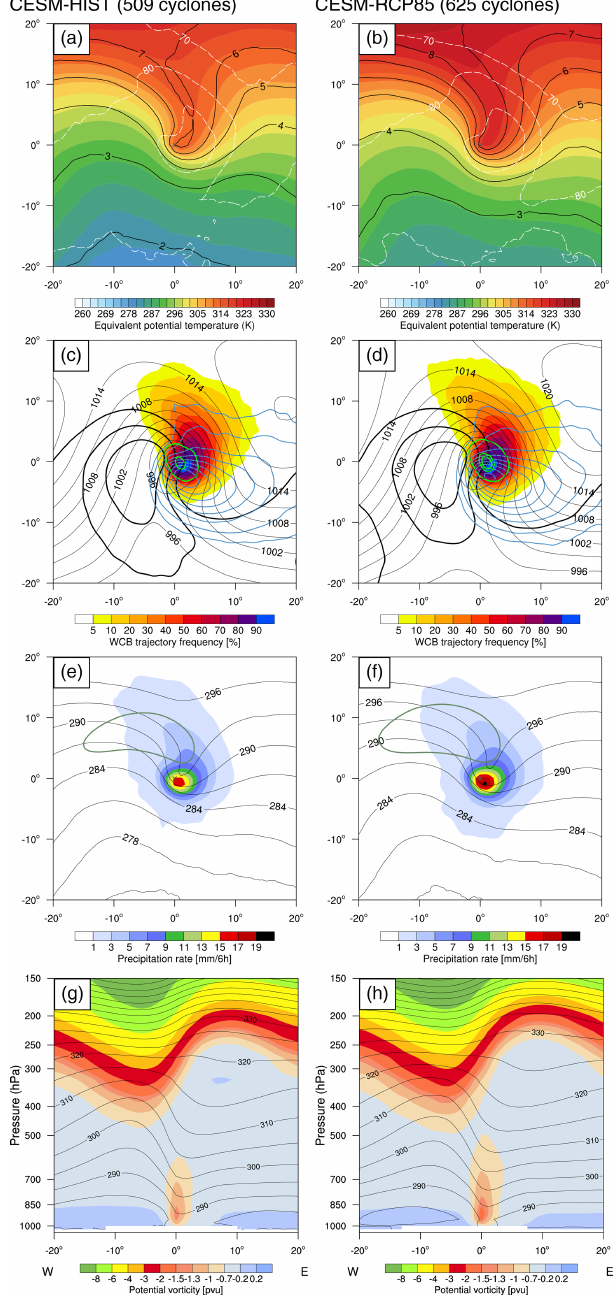
Figure 7. Composites of C1 cyclones in NH winter in (a, c, e, g) CESM-HIST and (b, d, f, h) CESM-RCP85 in the middle of the 24h period of strongest deepening. (a, b) Equivalent potential temperature (K; shading), specific humidity (black contours every gkg − 1 ), and relative humidity (dashed white contours every 10%) at 850hPa. Fields in (c) and (d) are as in Fig. 3a and b; fields in (e) and (f) are as in Fig. 3c and d; fields in (g) and (h) are as in Fig. 3e and f.